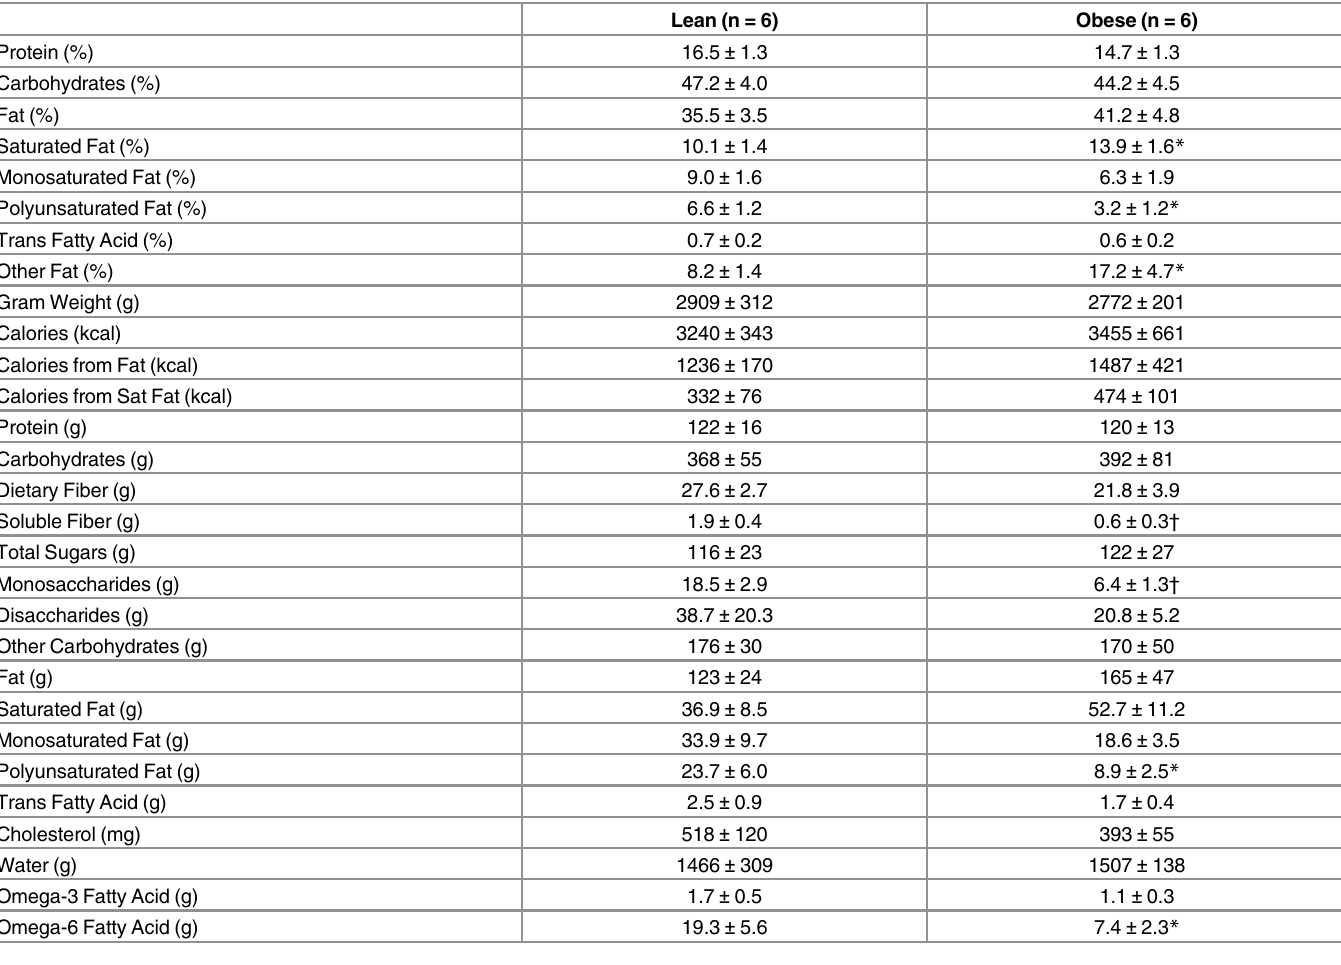
Table 2. Dietary